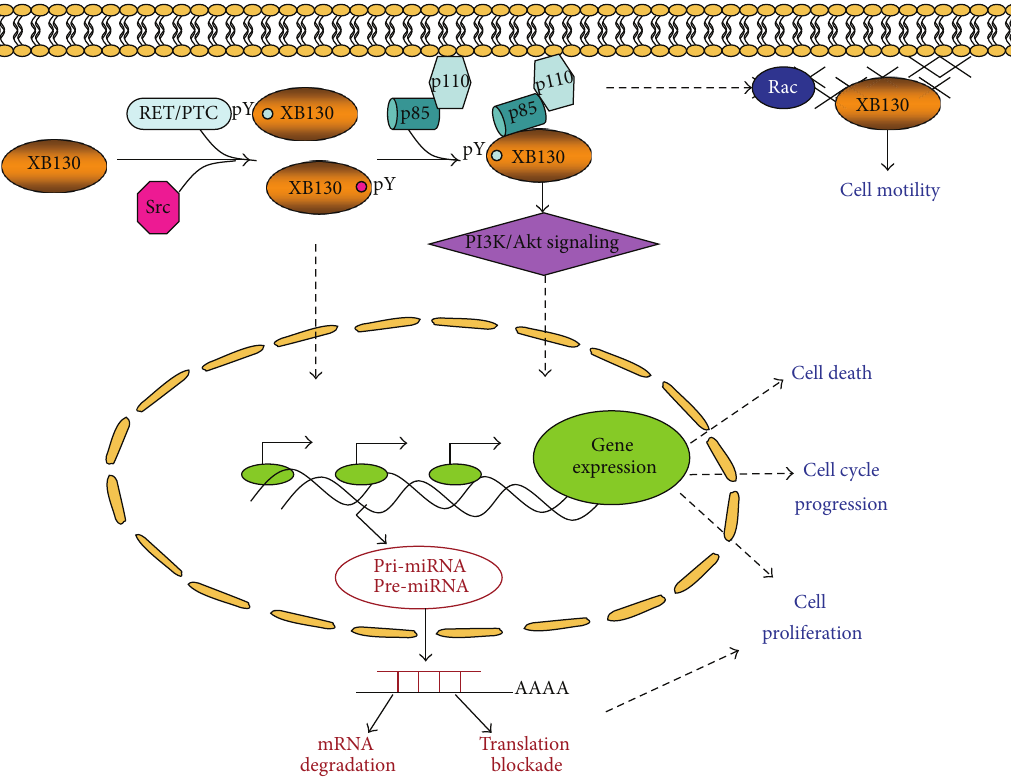
Figure 4: Summary of XB130 cellular